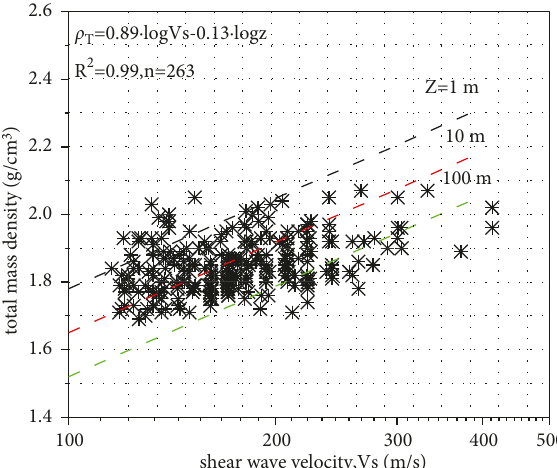
Figure 11: Correlation for specific density from depth and V